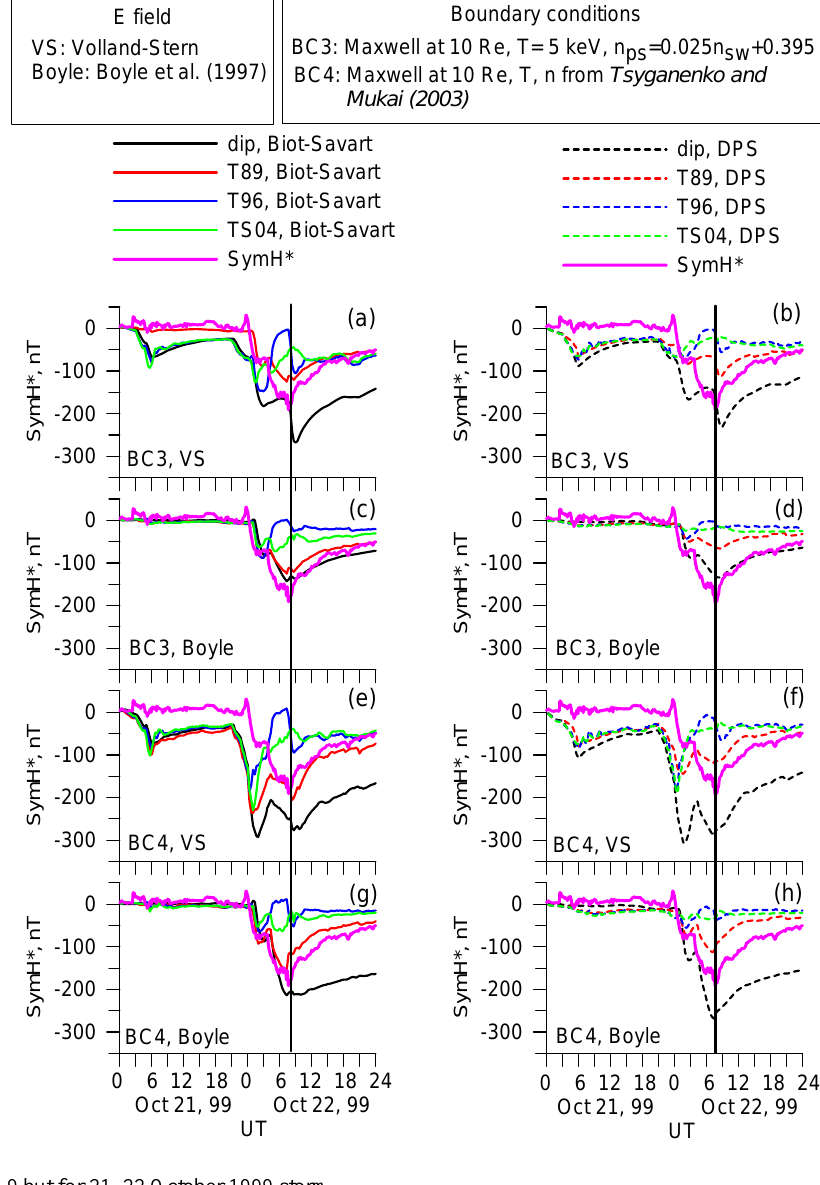
before and positives values mean after the storm maximum as defined by the UT of SymH* minimum,